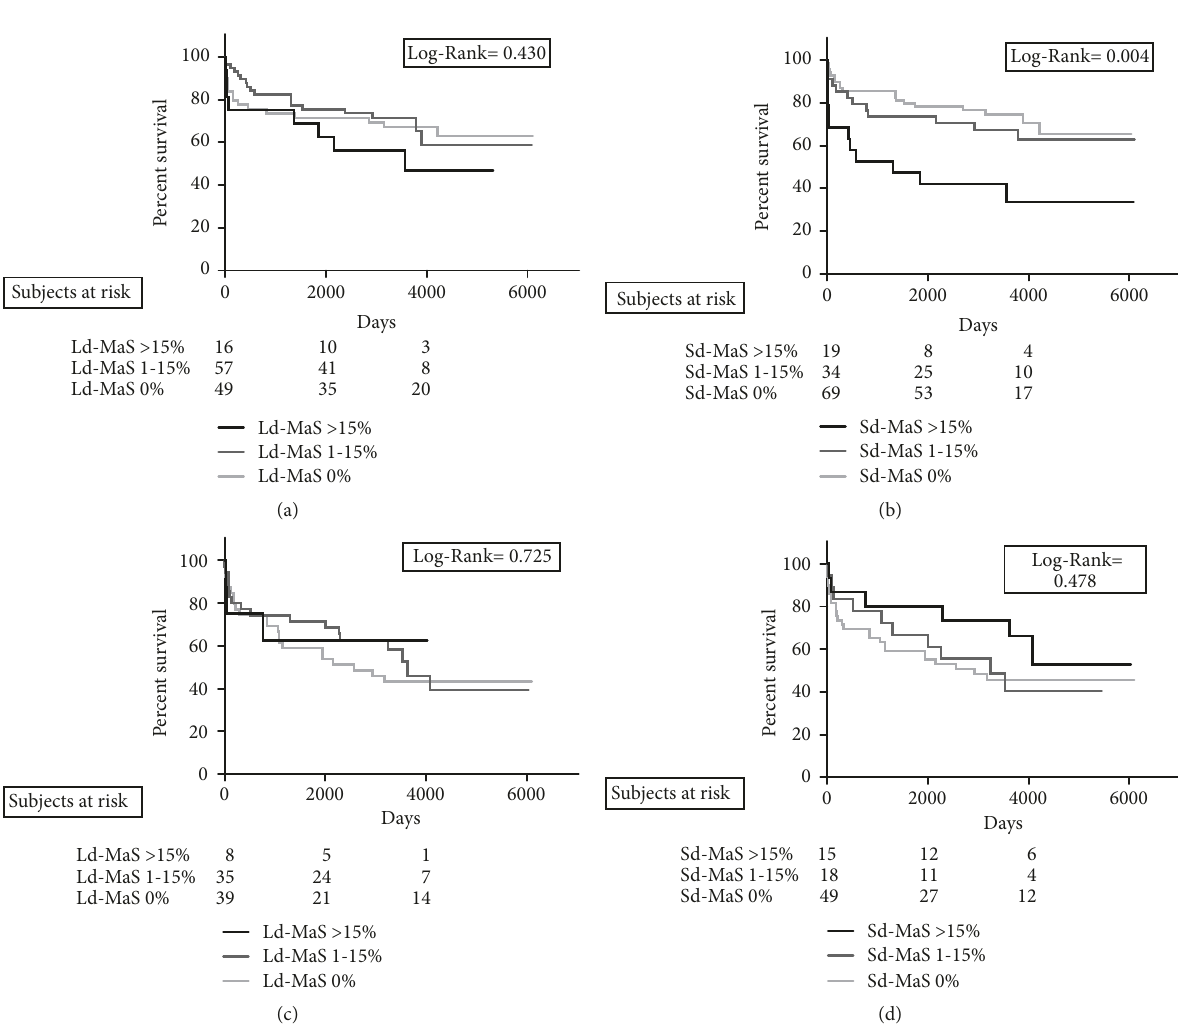
Figure 3: Cumulative overall graft survival rate according to graft large droplet (Ld-MaS; (a-c)) and small-droplet (Sd-MaS; (b-d)) macrovesicular steatosis distribution in recipients with HCV unrelated ((a), (b)) and related ((c), (d)) liver disease.